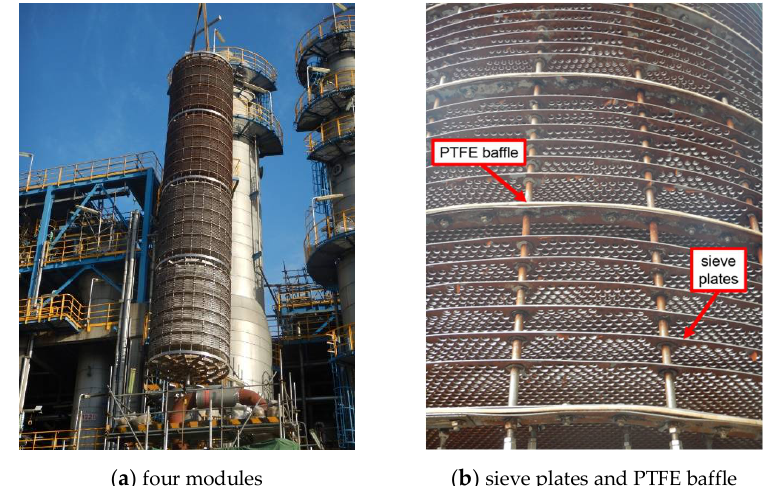
Figure 4. External appearances of the extraction column.